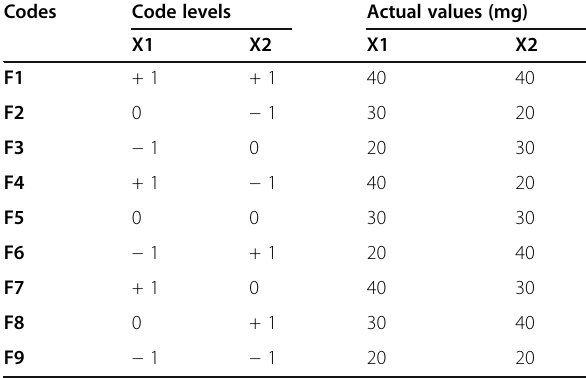
Table 1 Levels of independent variables in the tablet